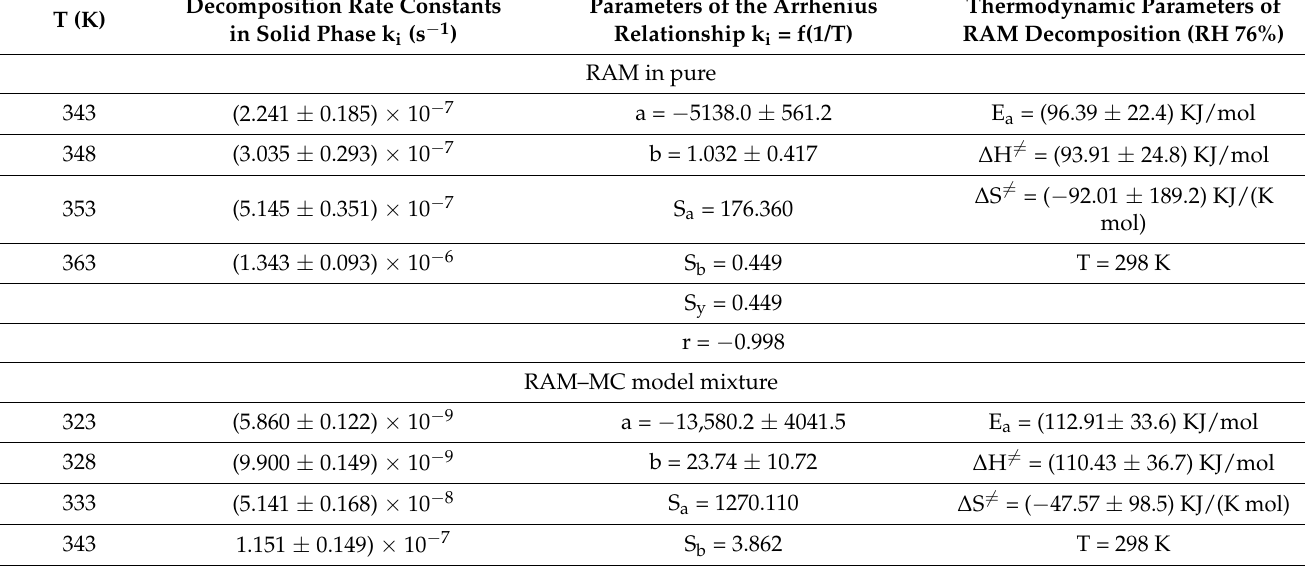
Table 3. Effect of temperature on the stability of pure RAM and RAM in model mixtures with excipients (RH 76.0%): kinetic and thermodynamic